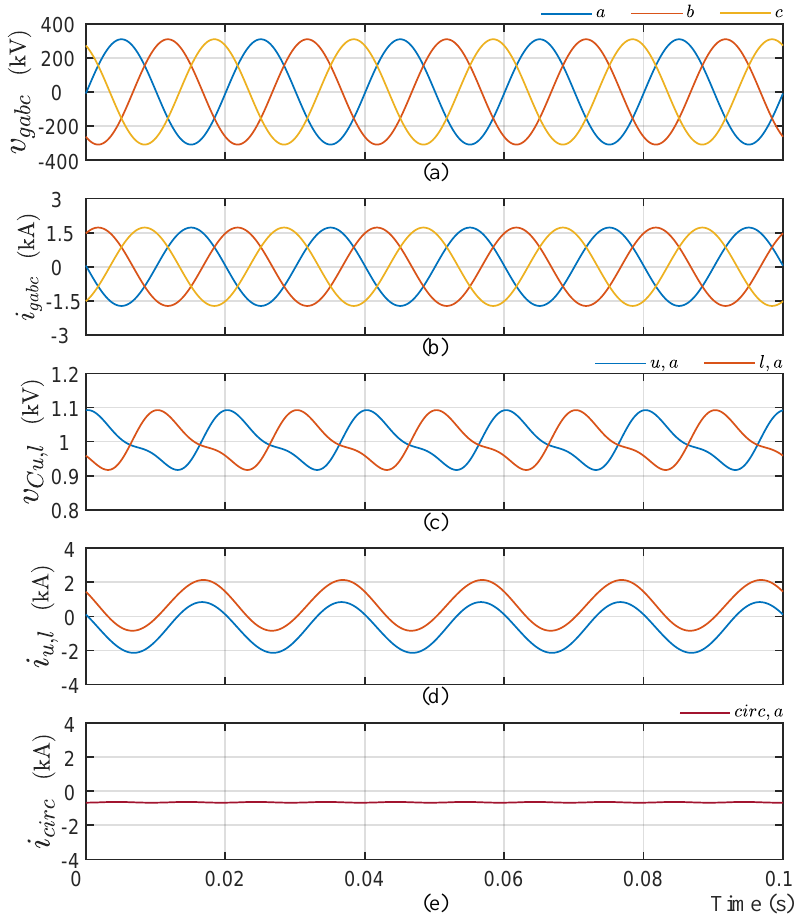
Figure 6. Steady-state operation of the MMC: ( a ) ac voltages, ( b ) ac currents, ( c ) average SM capacitor voltages of phase a , ( d ) arm currents of phase a and ( e ) circulating current of phase a